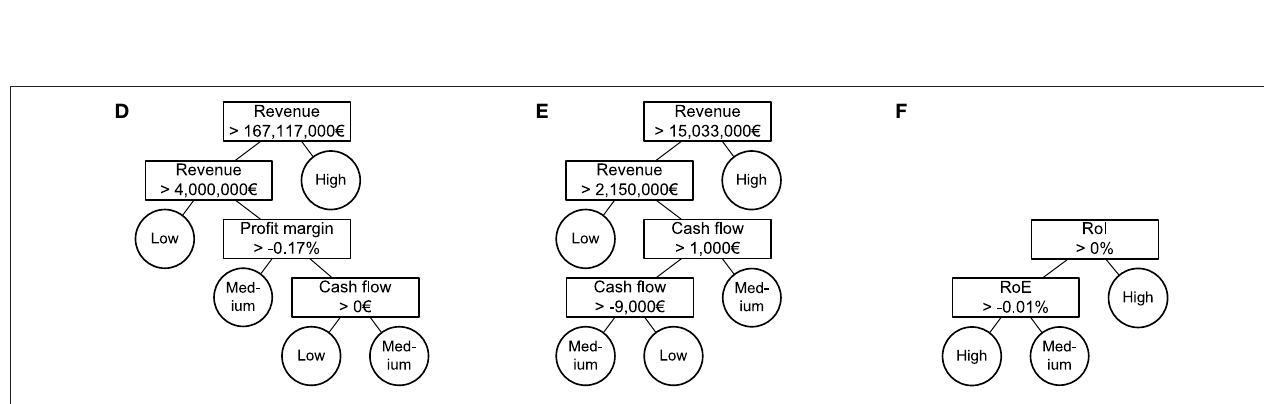
FIGURE 3 | Example models for Thresholder DNFs built on the three data sets. (A) Trade data set model. (B) Construction data set model. (C) Finance data set model.